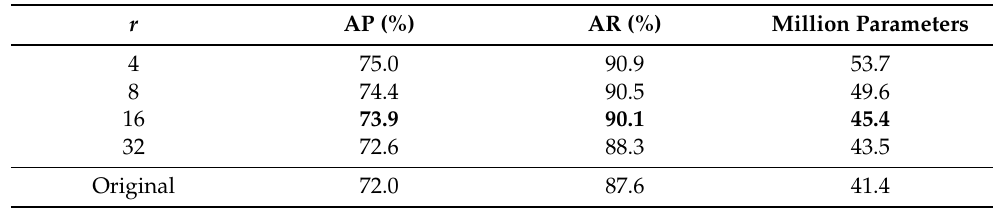
Table 1. AP, AR, and network parameter amount on AIR-SARShip-1.0 at different r . Here, original refers to Faster RCNN with ResNet-50.